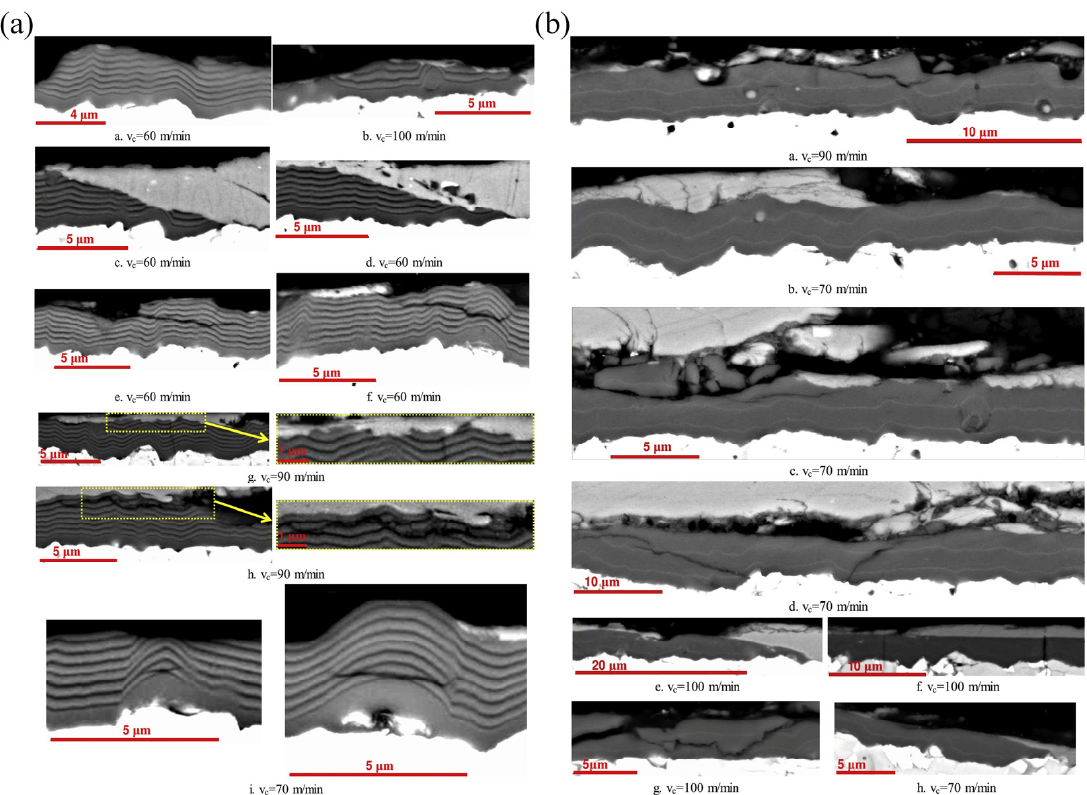
Figure 1. The fracture pattern on the Ti-TiN-(Ti,Al,Cr)N multilayer coatings with nanolayer thickness of ( a ) 302 nm and ( b ) 10 nm after the cutting tests with different cutting speeds (v c ). ( a ) With nanolayer thickness of 302 nm, the formation of longitudinal cracks and internanolayer delaminations is typical. ( b ) With nanolayer thickness of 10 nm, rarer internanolayer delaminations can be observed. Reprinted with permission from [59].